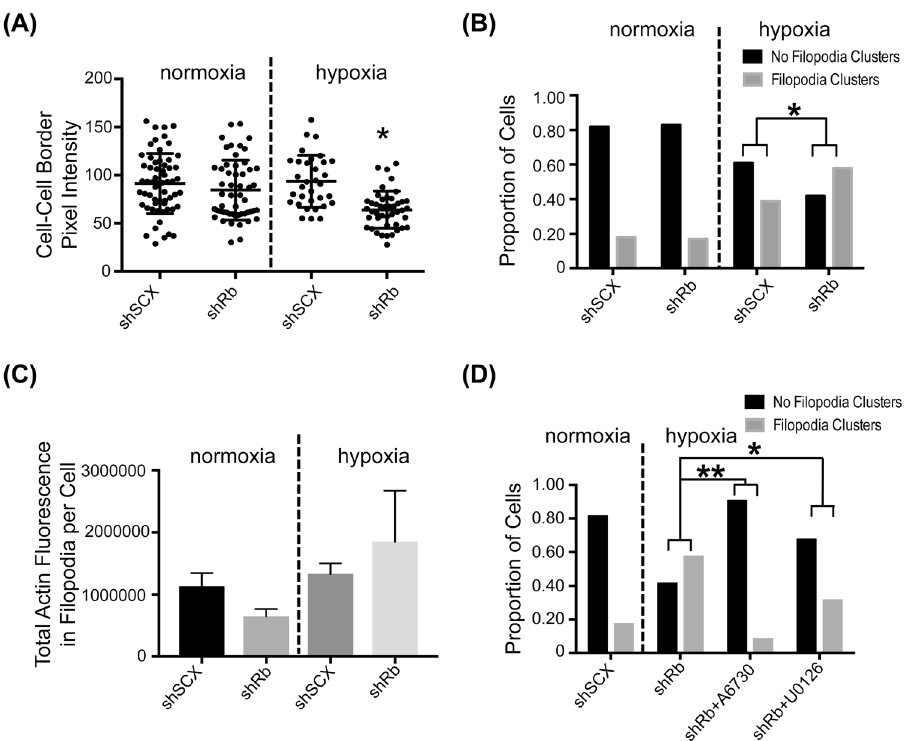
Figure 6. Rb-loss and hypoxia alter the LNCaP actin cytoskeleton. ( A ) Scatter plot of pixel intensities measured along cell-cell boundaries. A double-blind analysis of cell-cell boundaries from normoxic shSCX (n = 60) and shRb (n = 53) and hypoxic shSCX (n = 33) and shRb (n = 44) conditions was conducted using ImageJ software. Horizontal black bars represent mean pixel intensities ± S.D., differences between means were determined by a Kruskall-Wallis with Dunn’s multiple comparisons test, * p-value < 0.05. ( B ) Proportion of cells categorized as having either no filopodia-like clusters (black bars) or filopodia-like clusters (grey bars). Cells from normoxic shSCX (n = 141) and shRb (n = 134) and hypoxic shSCX (n = 95) and shRb (n = 123) conditions were categorized through a double-blind analysis of phalloidin staining. Differences between populations were determined with a Fisher’s exact test, * p-value = 0.0065. ( C ) Total actin fluorescence in filopodia clusters per cell was determined by multiplying the phalloidin staining intensity by the area of each measured filopodia cluster. Phalloidin staining intensity and area of filopodia clusters were determined through a double-blind analysis of confocal images using ImageJ software. Data represents means ± S.E.M. ( D ) Proportion of hypoxia conditioned shRb cells categorized as having either no filopodia-like clusters (black bars) or filopodia-like clusters (grey bars) after treatment with vehicle (n = 123), 2 µ M A6730 (n = 78) or 10 µ M U0126 (n = 103). Cells were categorized through a double-blind analysis of phalloidin staining. The normoxic shSCX cells (n = 141) are shown as a negative control. Differences between populations were determined with a Fisher’s exact test, * p-value = 0.0002, ** p-value <